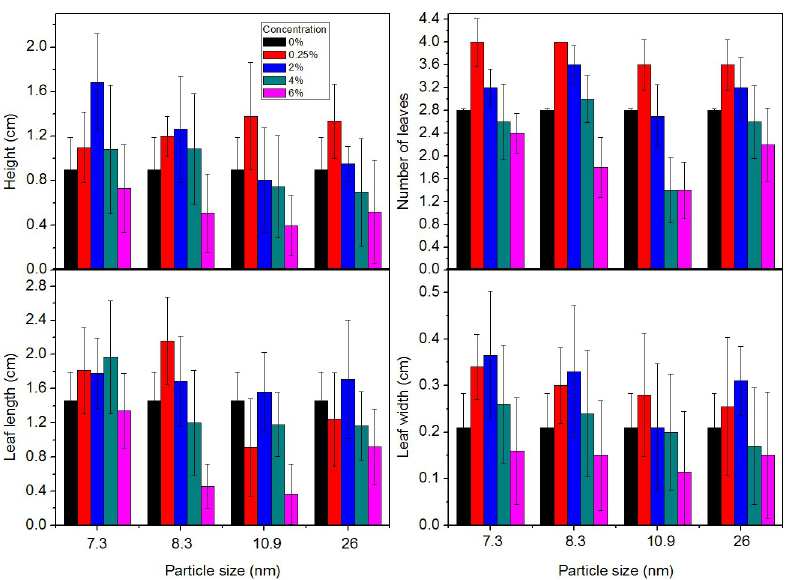
Fig 6. Morphological analysis of spinach plants. Morphological measures of spinach plants 16 days after the Ag-TiO 2 treatment.